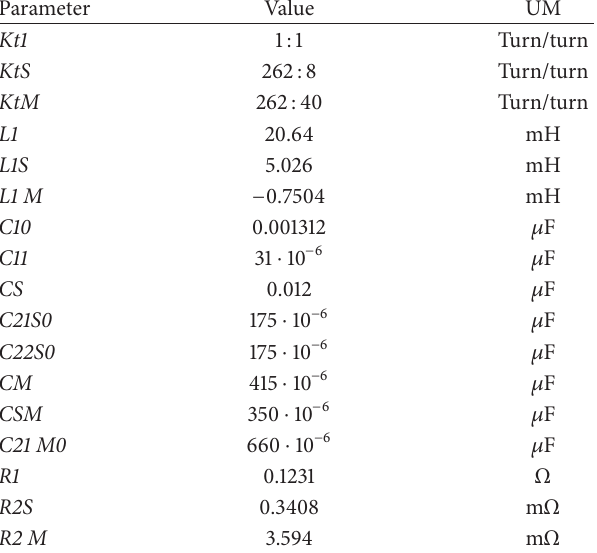
Table 3: Values of the primary transformer